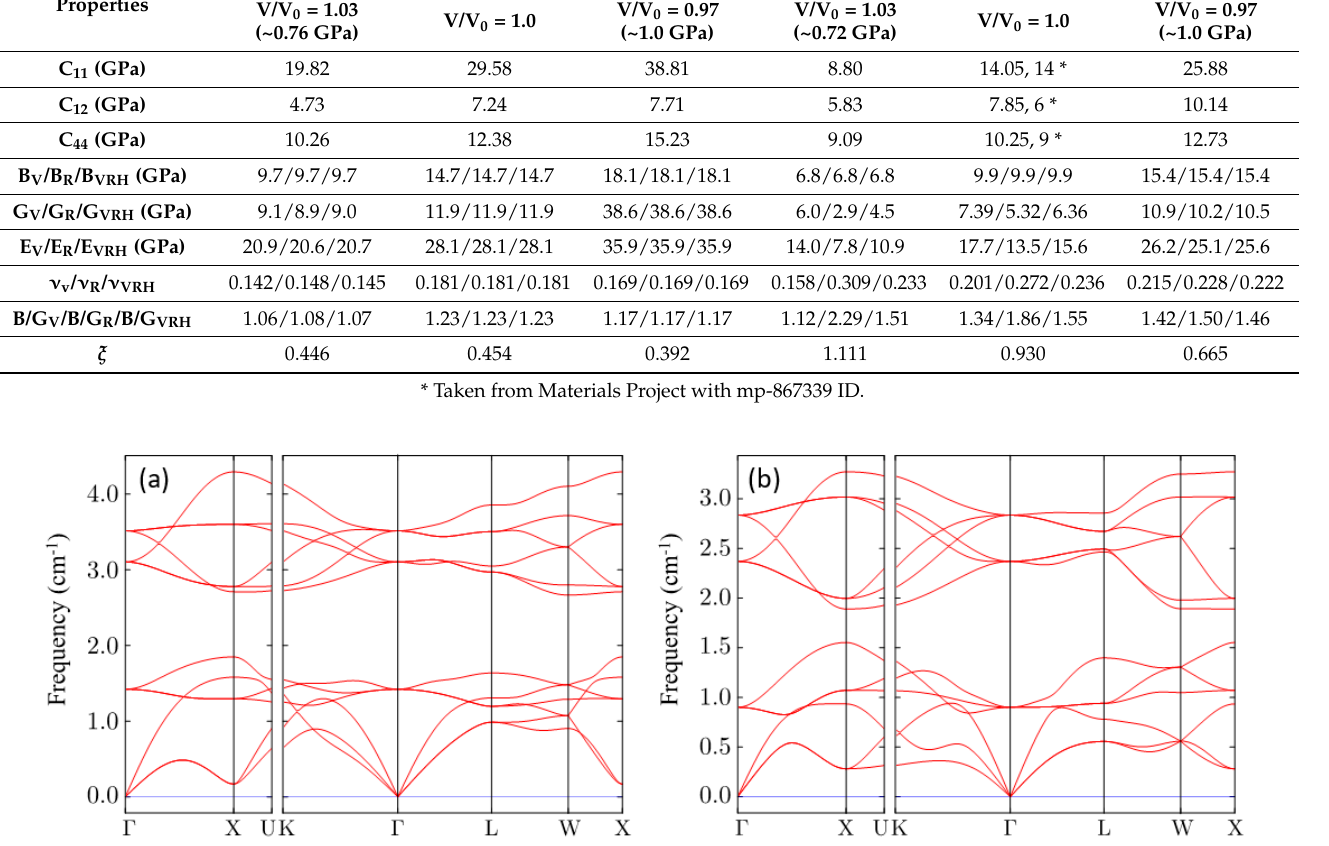
Figure 2. Phonon dispersion curves of the ( a ) CsNa 2 Bi and ( b ) CsK 2 Bi compounds along with high symmetry points in the Brillouin zone. It can be clearly seen that the phonon dispersion exhibits no imaginary frequency (soft phonon modes), confirming the dynamic stability of these compounds.